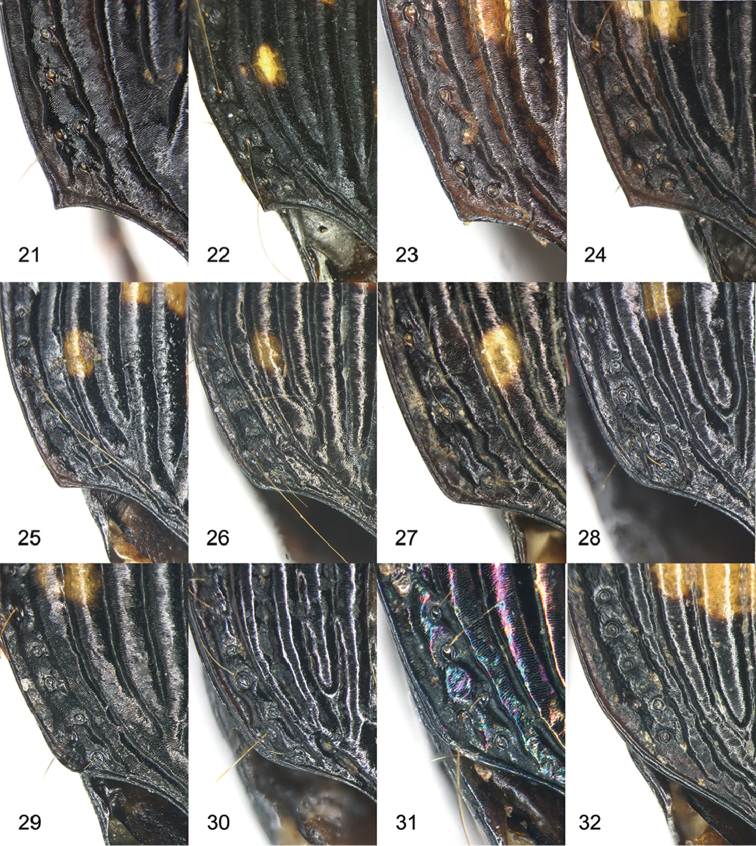
Elytral outer apical angle (left): 21
P.
acutidens sp. n., Yunnan (Ruli) 22
P.
ornatus
ornatus Schmidt-Göbel, Yunnan (Mengla) 23
P.
ornatus
ornatus Schmidt-Göbel, Vietnam (Tonkin) 24
P.
ornatus
ornatus Schmidt-Göbel, Hainan (Baisha) 25
P.
ornatus
formosanus Dupuis, Taiwan (Miaoli) 26
P.
ornatus
formosanus Dupuis, Taiwan (Nantou) 27
P.
obtusipennis Fedorenko, Yunnan (Pianma) 28
P.
obscuratus sp. n., Guizhou (Fanjingshan) 29
P.
amplus Andrewes, Myanmar (Putao) 30
P.
gibbosus sp. n., Myanmar (Putao) 31
P.
elegans sp. n., Xizang (Mêdog) 32
P.
dux Andrewes, Yunnan (Jinghong).